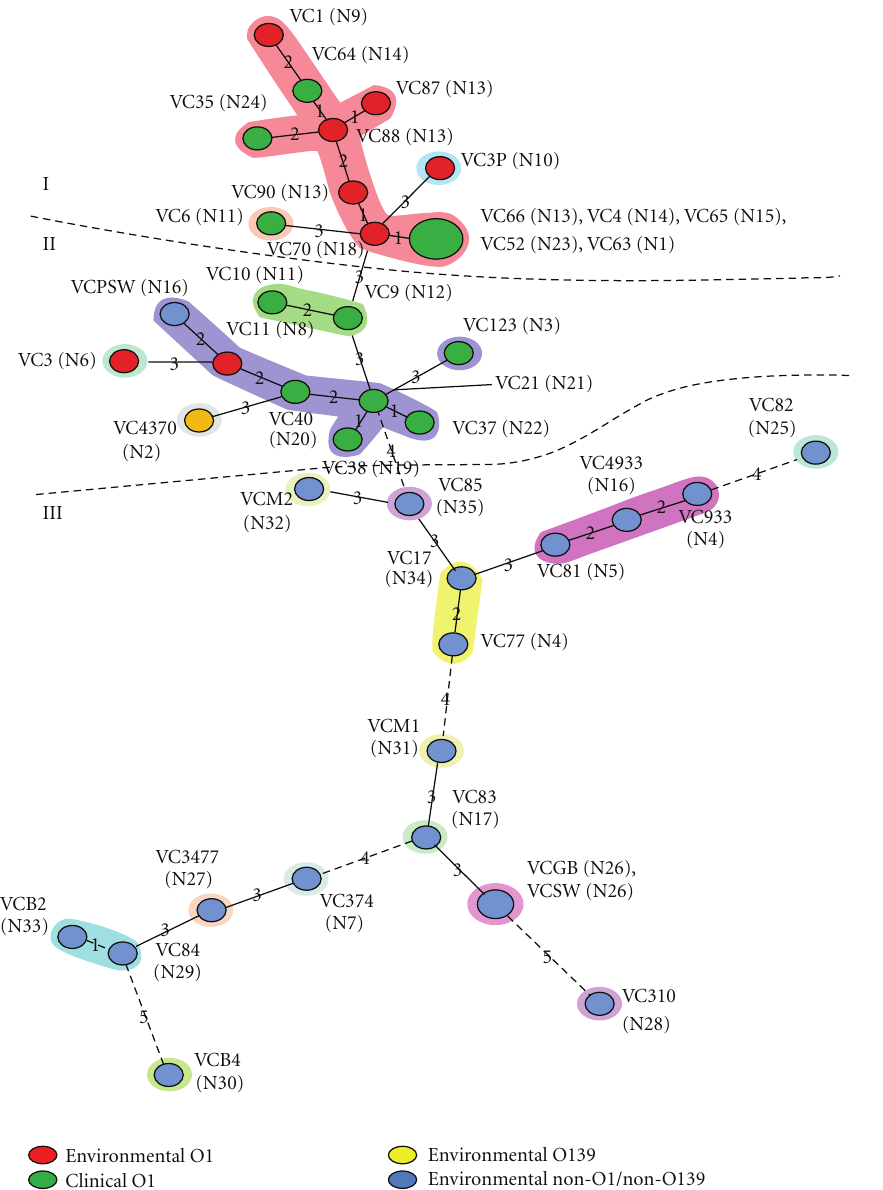
Figure 1: The relationship between 38 MLVA genotypes identified among 43 V. cholerae isolates using Minimum Spanning Tree analysis. The highlighted branches indicate the close relationship between strains (1-2 alleles di ff erence). The dotted line shows the gap between O1/O139 strains and non-O1/non-O139